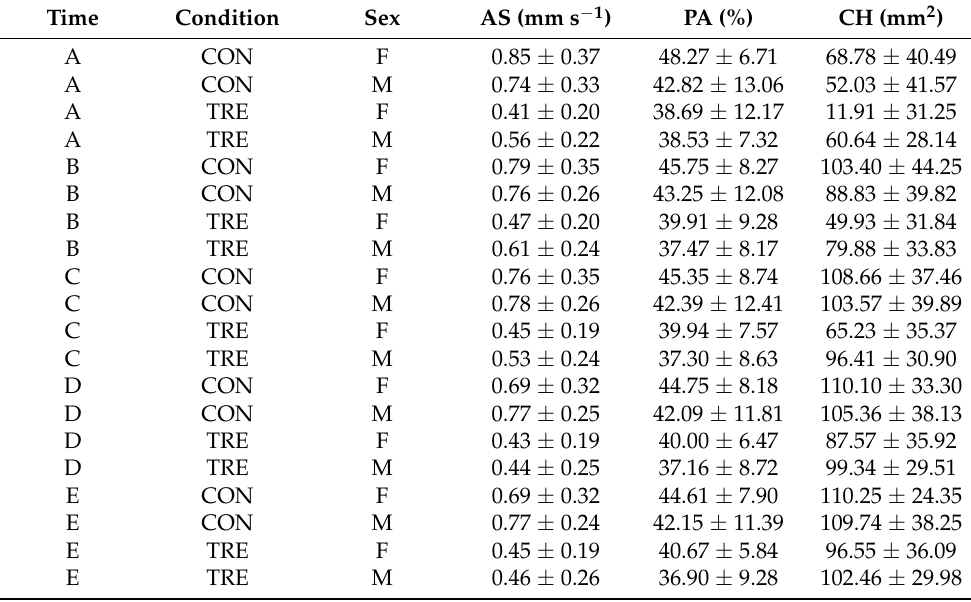
Table 1. Statistical summary of the analysed trajectory parameters (mean ± SD; n = 20). AS = average speed; PA = percentage of activity; CH = trajectory convex hull area. A = 1 min of recording, B = 2 min of recording, C = 3 min of recording, D = 4 min of recording, E = 5 min of recording. CON = control, TRE = treatment. F = female; M =